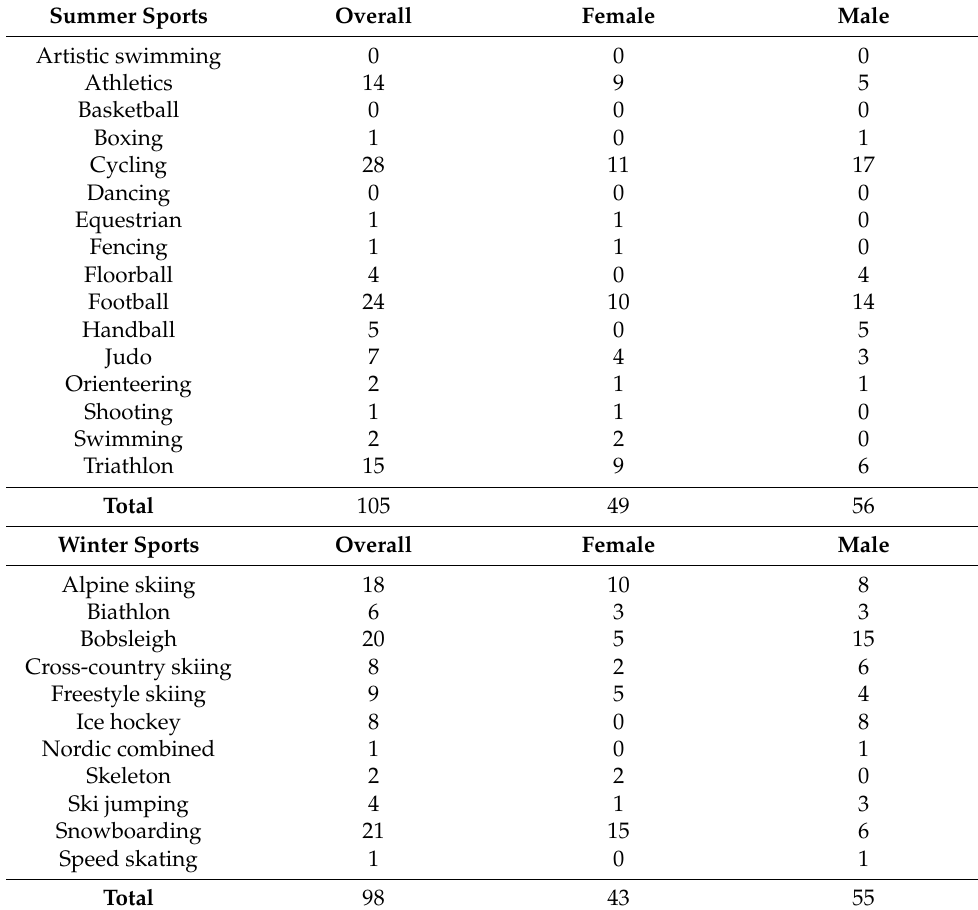
Table 2. Sport disciplines of the